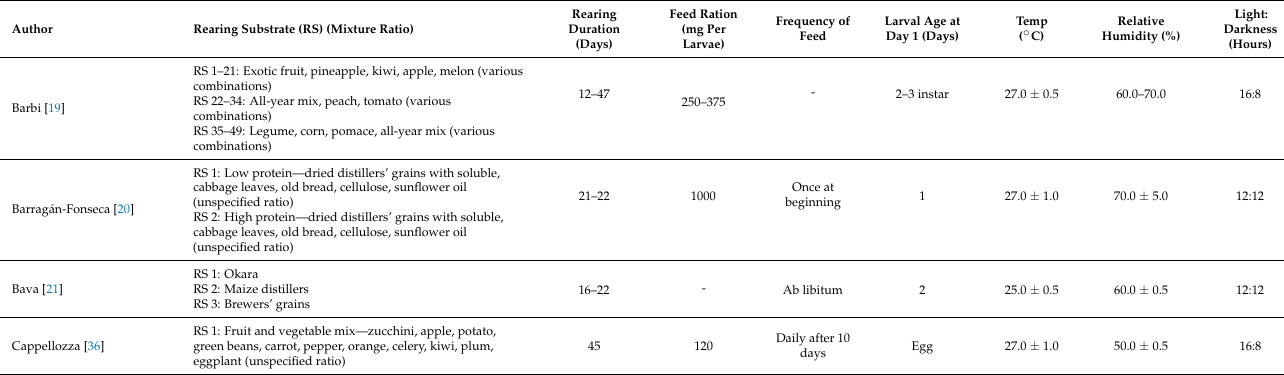
Table 1. Rearing substrates (RS) and rearing conditions of the BSF